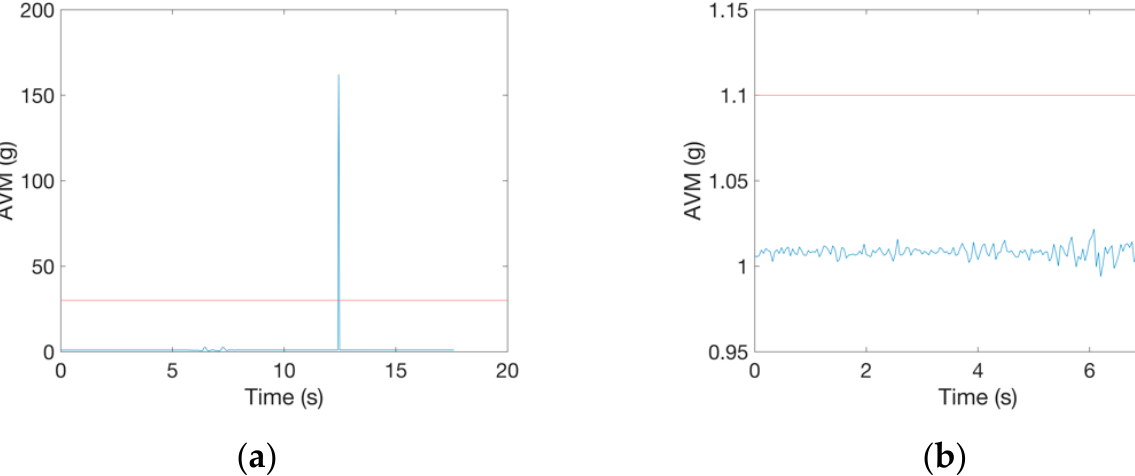
Figure 3. Examples of fall records in the ErciyesUni dataset excluded from further analysis due to: ( a ) the maximal AVM peak value larger than 30 g and ( b ) the maximal AVM peak value lower than 1.1 g.